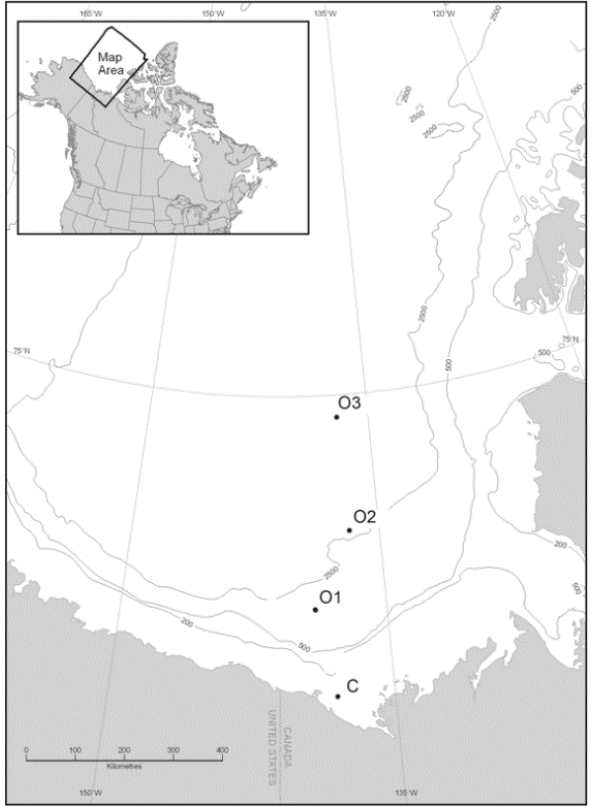
Figure 1. Sampling sites in the Beaufort Sea. C, coastal; O, offshore.